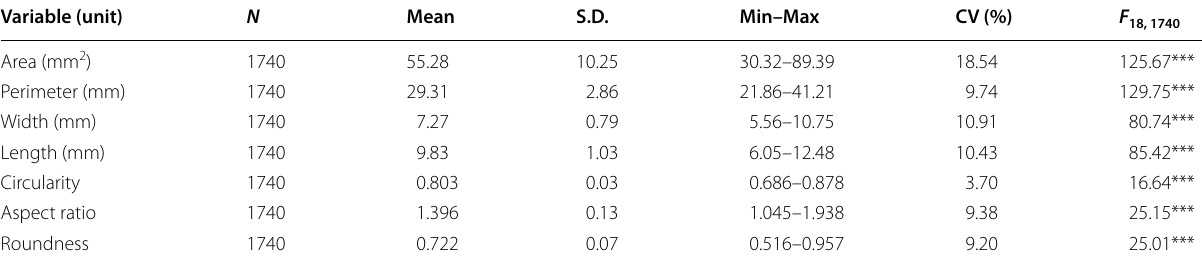
One-way ANOVA tests result and coefficient of variation (CV%) per seed trait are given Values labeled with “ *** ” are statistically significant at P < 0.001; N , number of seeds used in the analysis; S.D., standard deviation; Min, minimum value; Max, maximum value